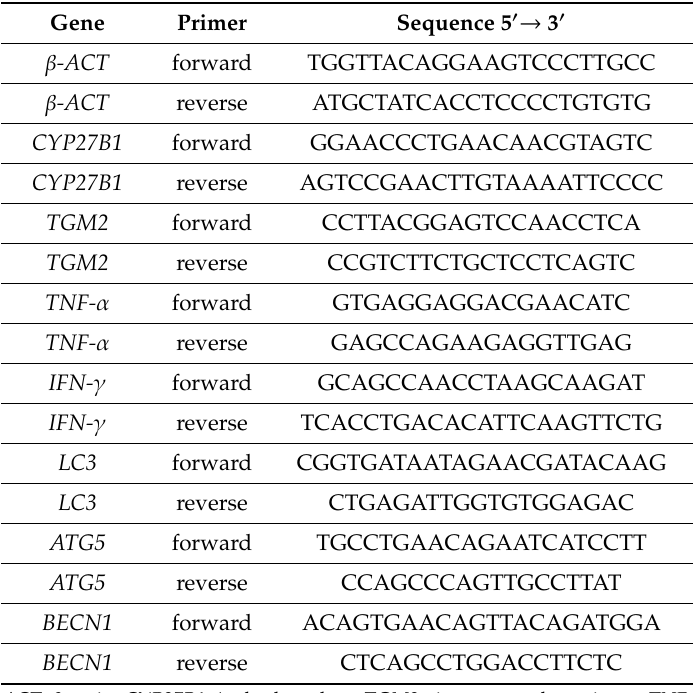
Table 3. Primer sequences used for SYBR green real-time